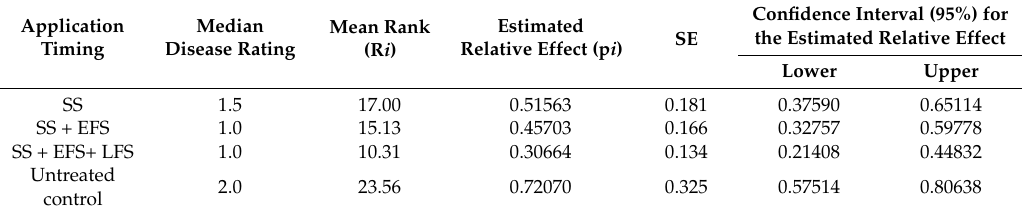
Table 4. Median rank and estimated relative effects (p i ) of pyraclostrobin application (92.5 g ¨ a.i. ¨ ha ´ 1 ) on blackleg severity on the canola hybrid “1950RR” at Edmonton (Crop Diversification Centre North; CDCN) in 2014 and 2015, and at Namao, Alberta, in